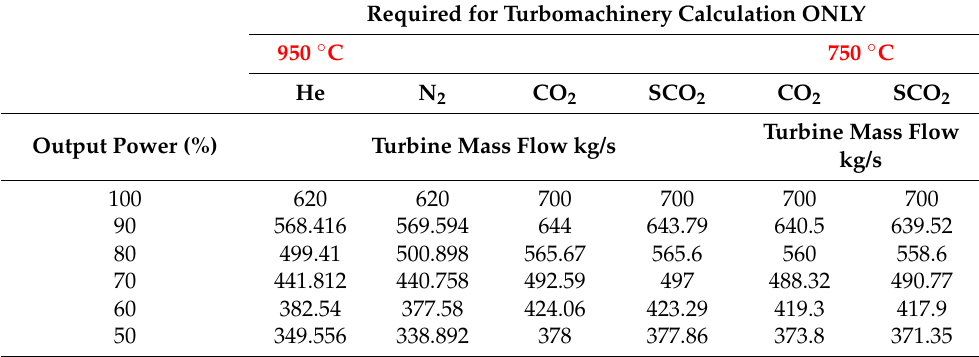
Table 3. Turbine mass-flow rates